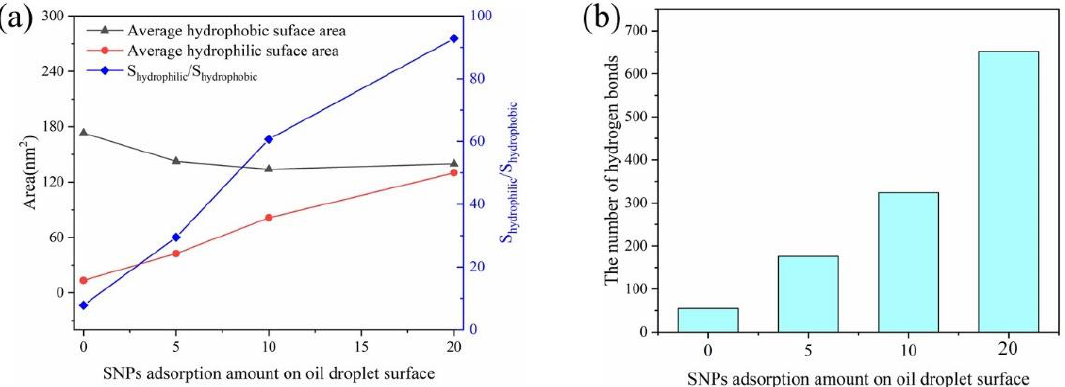
Figure 5. Average hydrophobic and hydrophilic surface areas of emulsified oil droplets ( a ). The number of hydrogen bonds formed between oil droplet and water molecules ( b ).